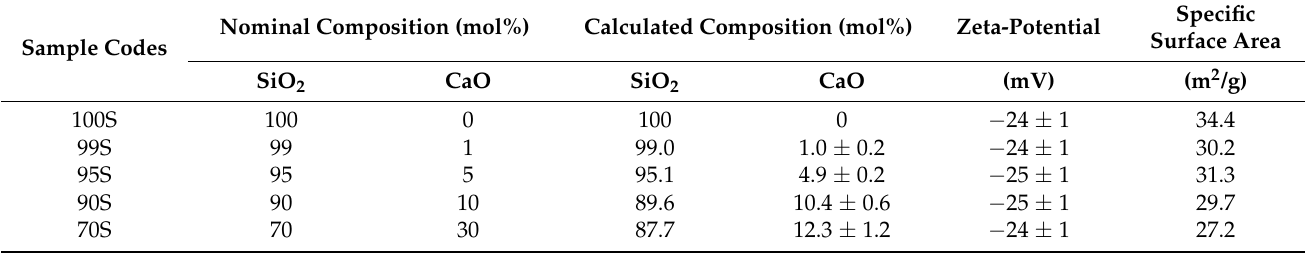
Table 2. Nominal and calculated compositions of BGNs determined by EDS results as well as the zeta potential and specific surface area.